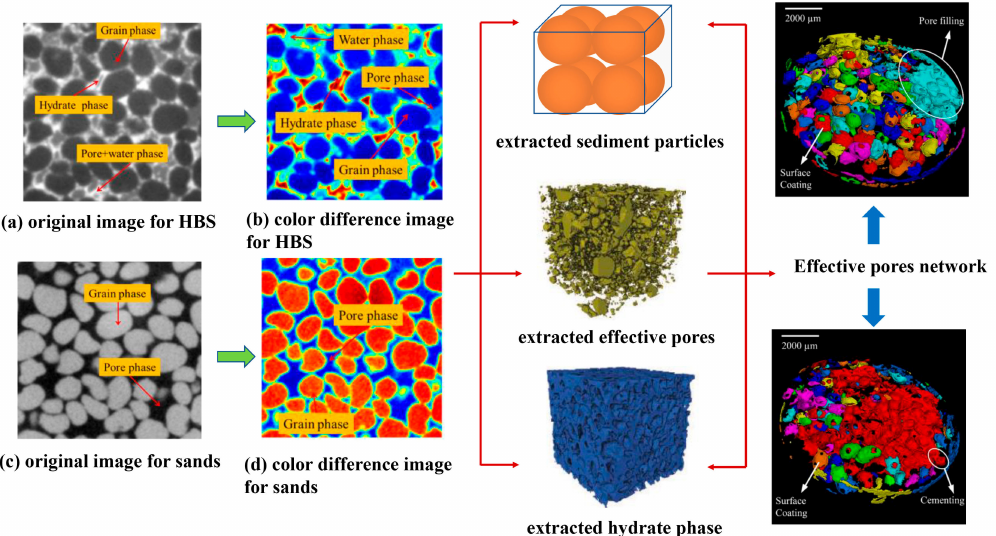
Figure 9. Analytical workflow of the pore-structure characteristics of the hydrate-bearing sediments using digital core method based on CT scanning (pores and phase from Zhang [87], ( a – d ) from Zhao [88], pore network from Jarrar